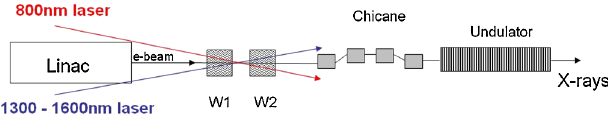
FIG. 1. (Color) Schematic setup for the two-color